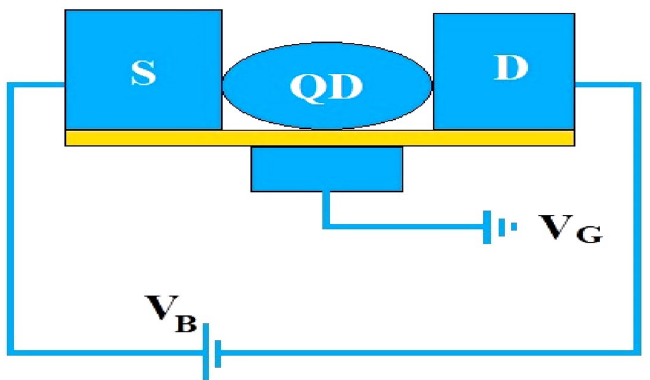
Figure 1. Schematic diagram of an SMT device showing a QD placed on a substrate and connected to source S and drain D. V B is the bias voltage and V G is the gate